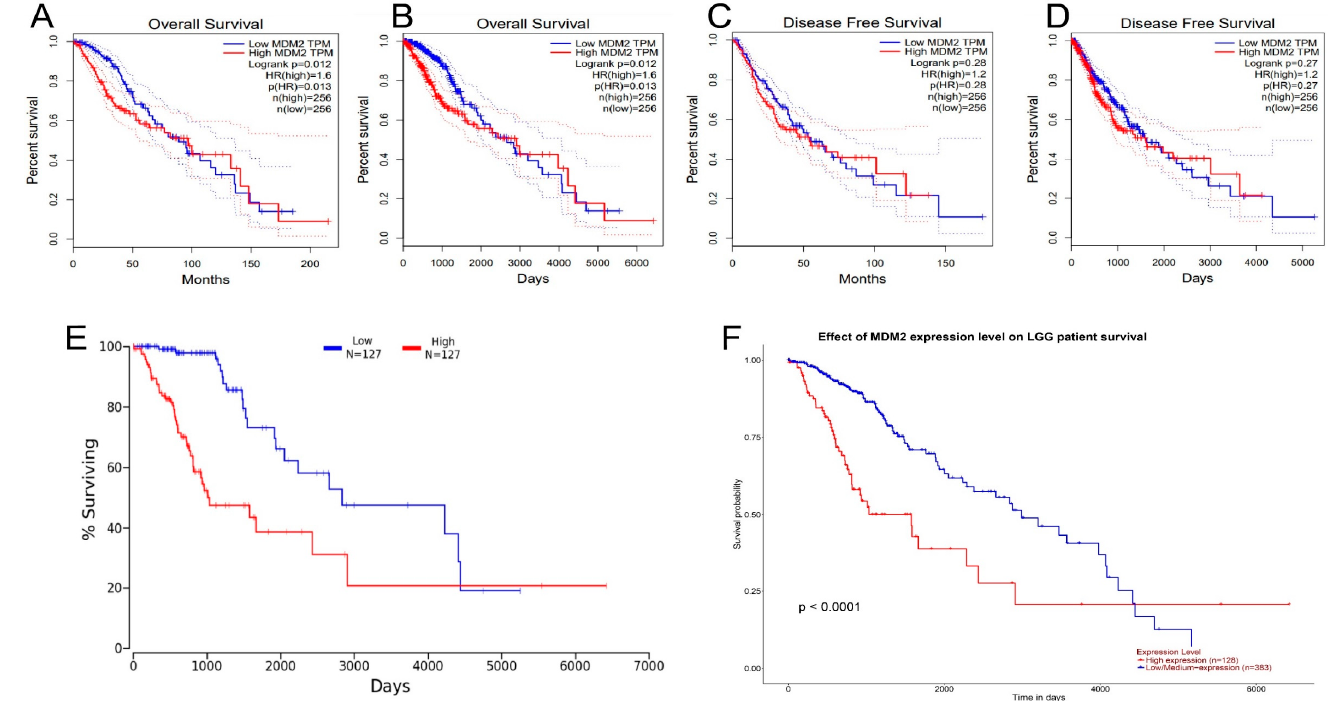
Figure 6. The analysis of survival assay for MDM2 gene in brain lower-grade glioma cancer (LGG). The analysis of survival plots has been depicted from GEPIA, Onco-Lnc, and UALCAN servers. Here, the plots were ( A ) survival rate (overall) per month, ( B ) survival rate (overall) per day, ( C ) diseases-free survival per month, ( D ) diseases-free survival per day, ( E ) survival plot collected from Onco-Lnc database, ( F ) survival data from UALCAN server.